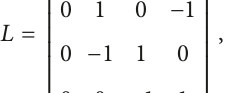
where 𝜆 1 = 2, 𝜆 2 = 0, 𝜆 3 = 1.5 + 0.866𝑖 , and 𝜆 4 = 1.5 − 0.866𝑖 are all eigenvalues of 𝐿